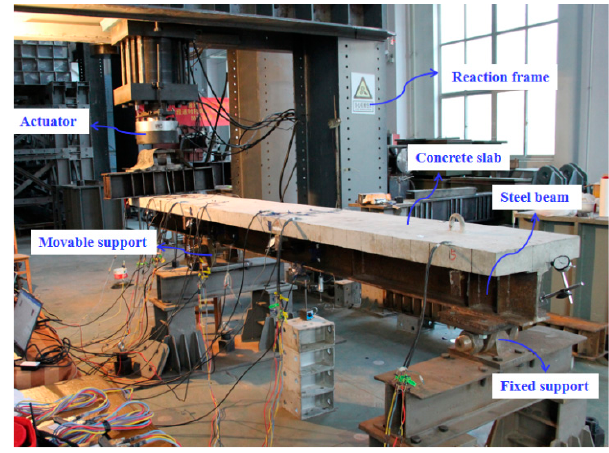
Figure 3. Experimental setup.